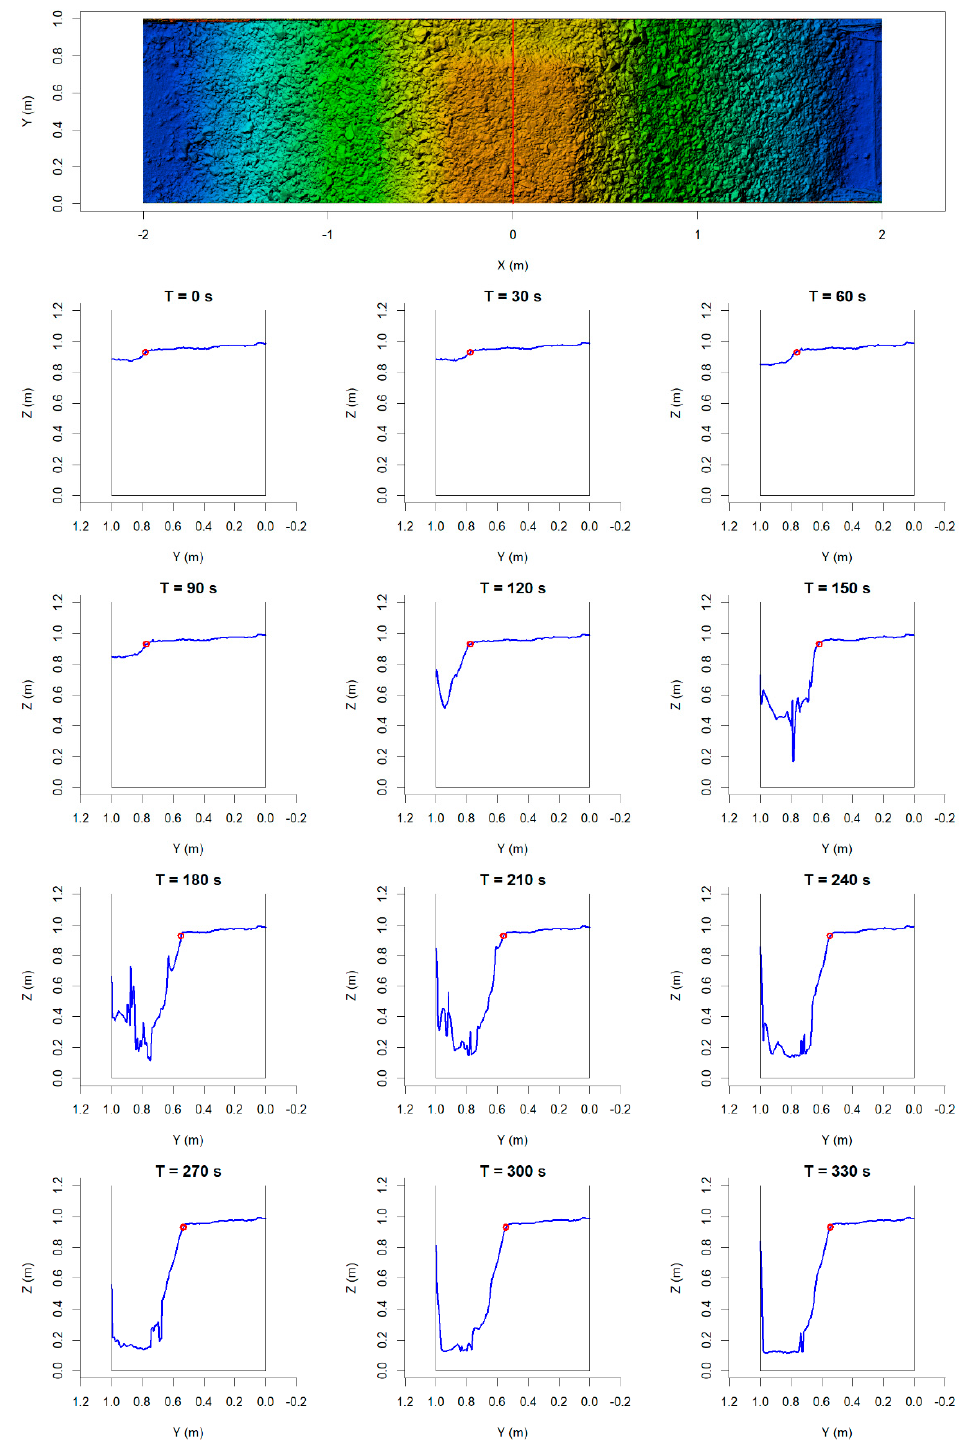
Figure A1. Cross-section profiles for X = 0 m (centre line) extracted from U1 dynamic 3D model; T = 0 s is immediately before initial observed erosion at downstream edge of crest; red circle indicates breach edge as used in further analyses.